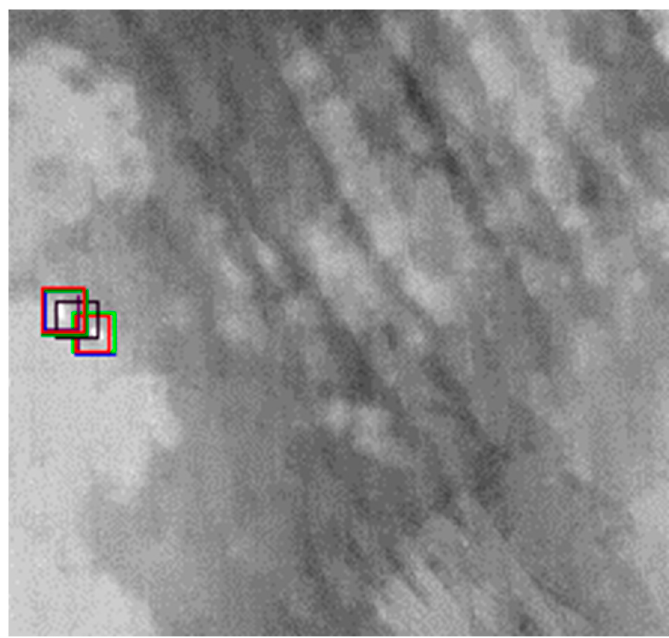
Figure 1. Single frame showing two objects, each with overlapping bounding boxes, that have been recognised by different component detectors within an ensemble. The different coloured boxes represent different component detectors. The strength of the outline represents the confidence value assigned to each detection.